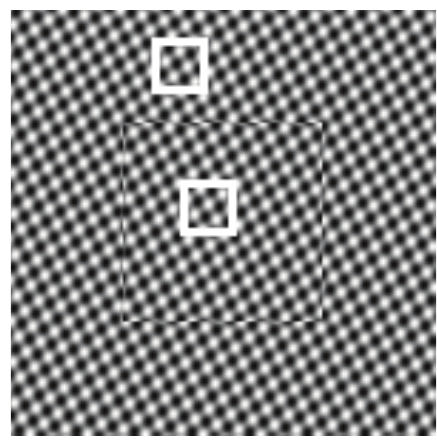
Figure 8: A frame of synthetic image